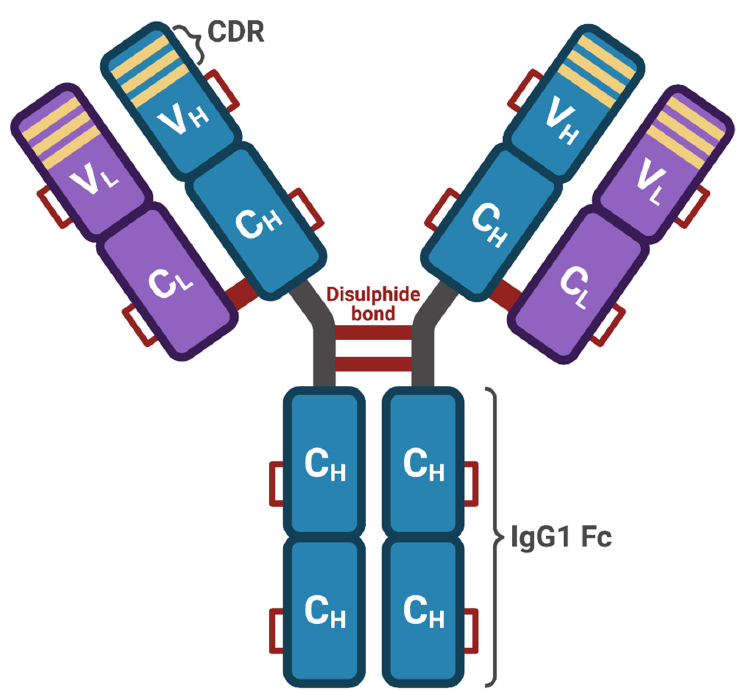
Figure 4. Tocilizumab structure. Tocilizumab is a recombinant humanized IgG1 κ antibody, con- sisting of two identical light chains, each one including a variable (V L ) and a constant (C L ) domain, coupled to two identical heavy chains, each one including a variable domain (V H ) and three con- stant domains (C H ). Overall, this antibody structure includes 12 intrachain and 4 interchain disul- fide bonds. The variable portion of tocilizumab includes the complementarity-determining regions (CDR), which bind the IL-6 receptor. This original figure was created by the authors using BioRen-